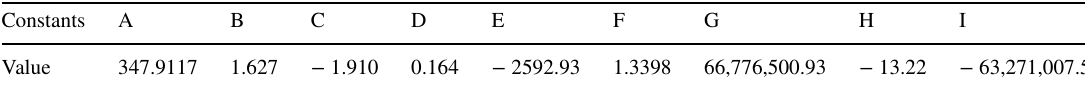
Fig. 19 Peq versus T plot of experimental data (N 2 hydrates) with “new correlation,” AAD = 0.74%